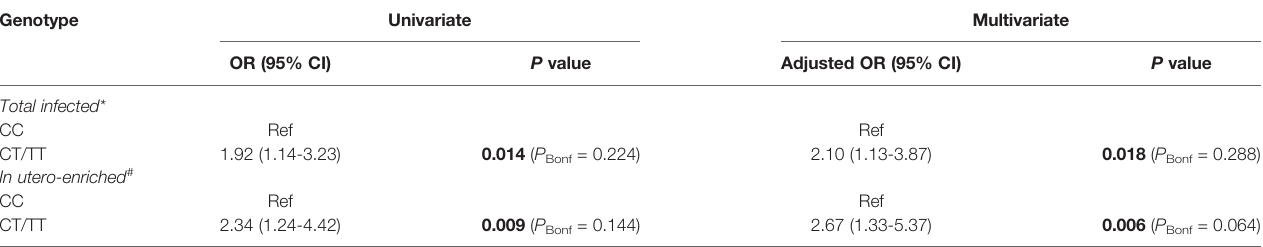
TABLE 5 | Effect of FCGR2C c.134-96C>T on perinatal acquisition of HIV-1 in study cohort with information on maternal viral load.